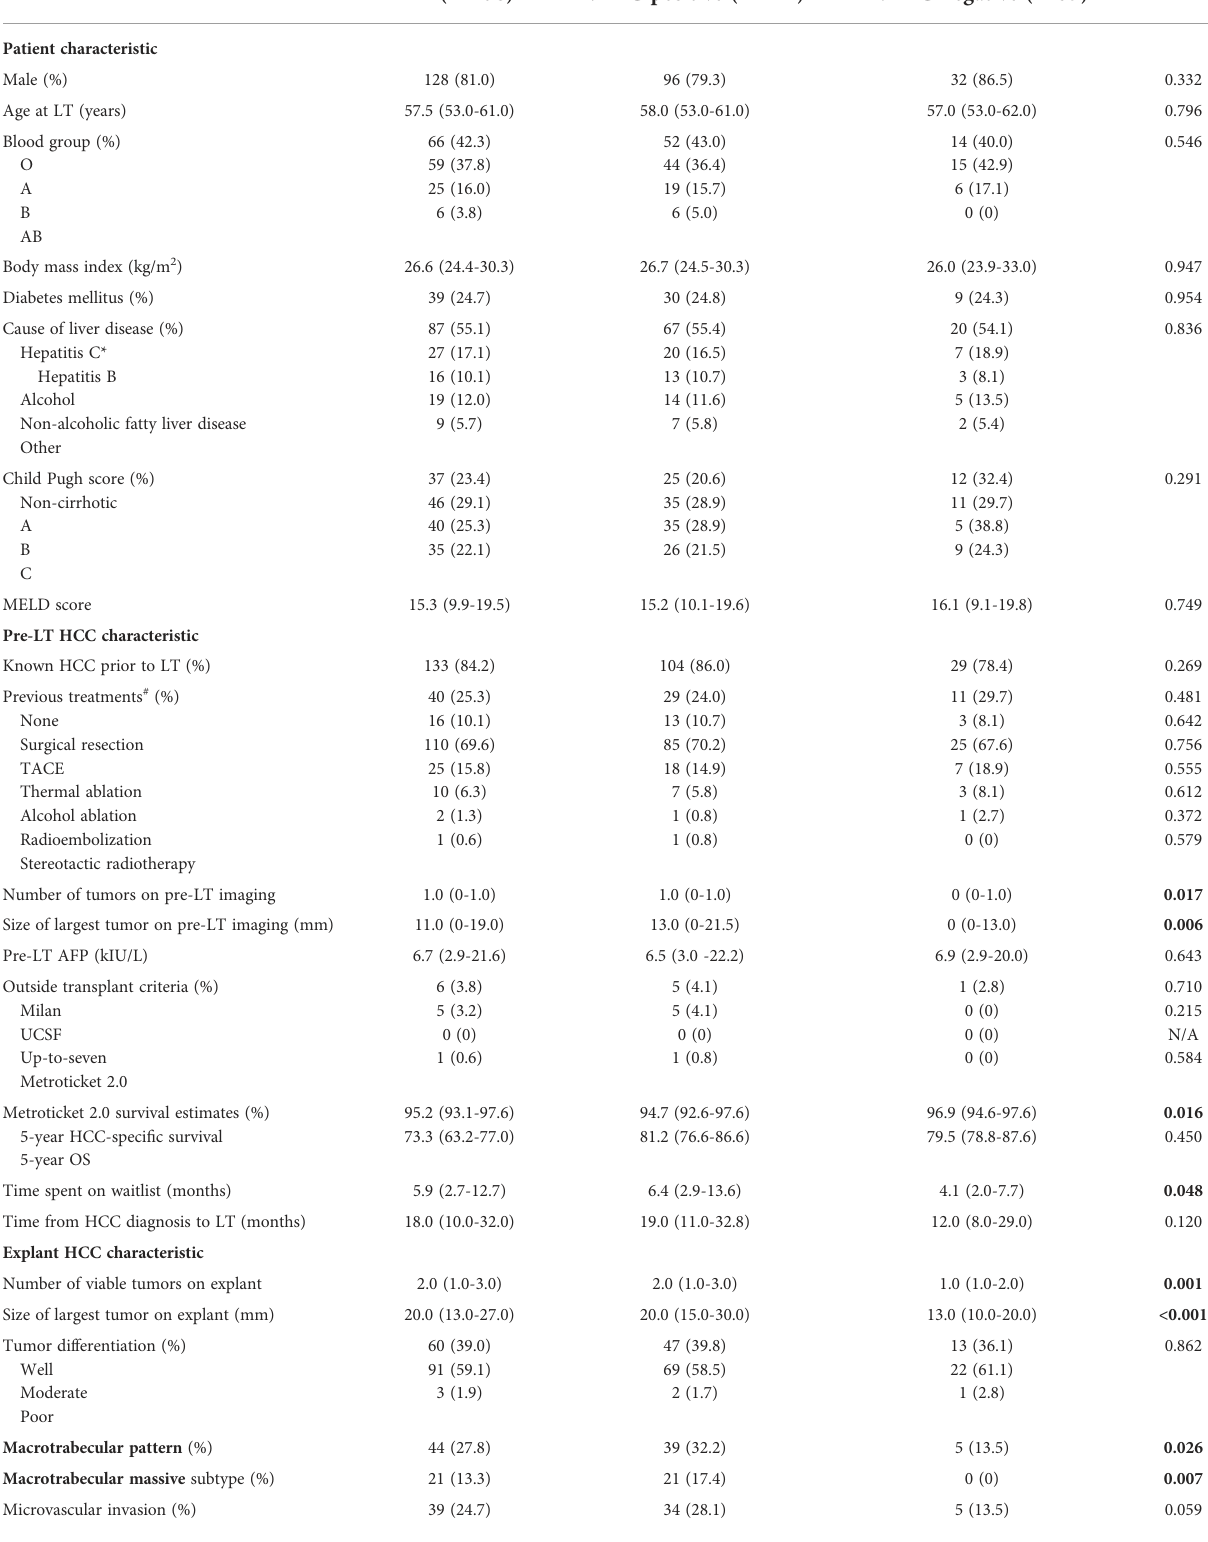
TABLE 1 Patient and tumor characteristics in VETC-positive and VETC-negative